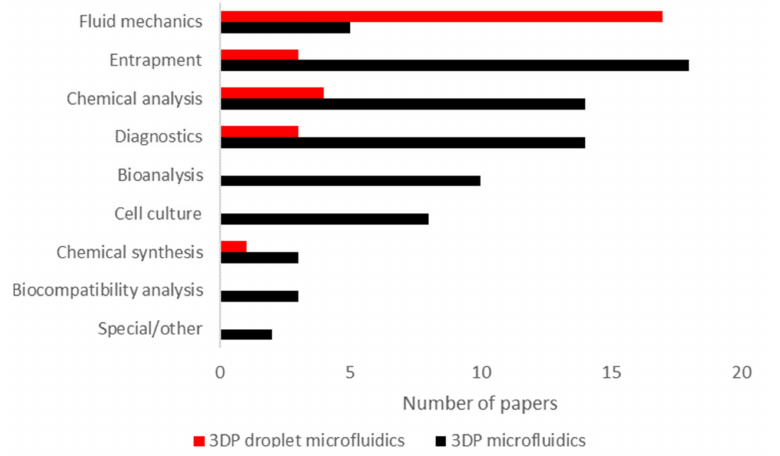
Figure 7. In the last five years, most 3DP droplet microfluidics applications were limited to fluid mechanics, whereas overall 3DP microfluidics saw the most applications in the entrapment of microparticles. Application categories are defined in detail the text. From a total of 106 surveyed 3DP microfluidics papers (for detailed information, please see Table S2), 30 were specific to droplet microfluidics. Most of these only focused on basic fluid mechanics, including droplet generation and manipulation. This shows that the field is still at an early stage. Out of all the papers, the most popular application areas of 3DP microfluidics were microparticle entrapment, chemical analysis and